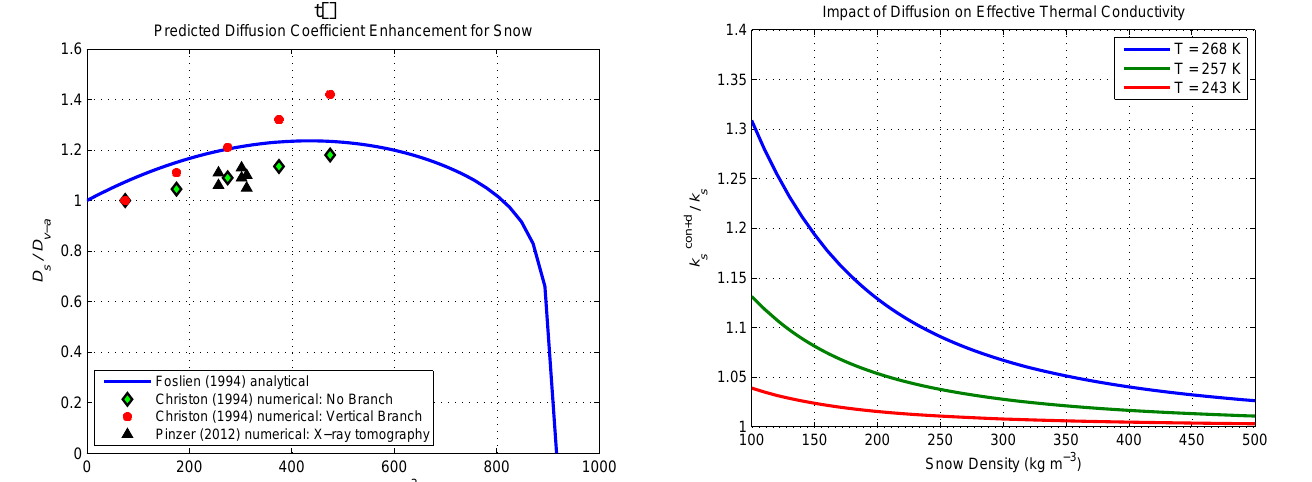
Figure 8. Effective thermal conductivity enhancement due to diffu- sion predicted by Foslien